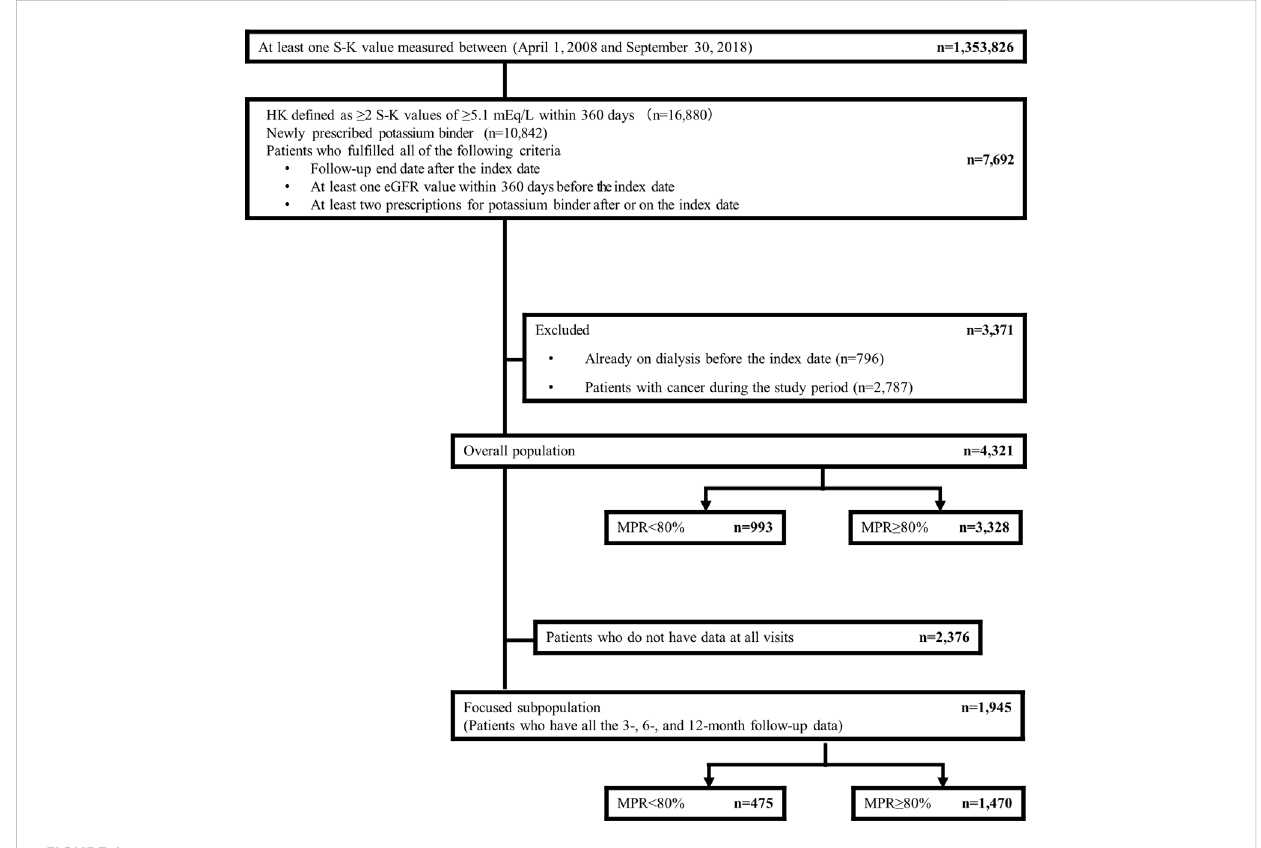
Flow diagram of patient inclusion in the